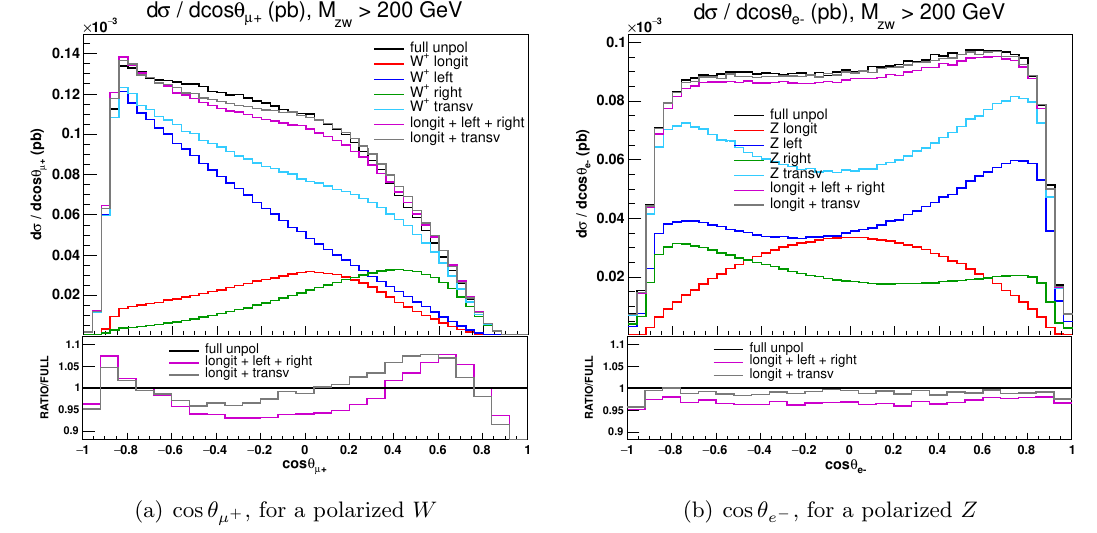
Figure 12 . W + Z scattering: comparison of transverse to left+right Standard Model distributions in cos (cid:18) and cos (cid:18) distributions, in the (cid:12)ducial region ( M WZ > 200 GeV). The full set of (cid:22) + e (cid:0) kinematic cuts (see section 5.1) is